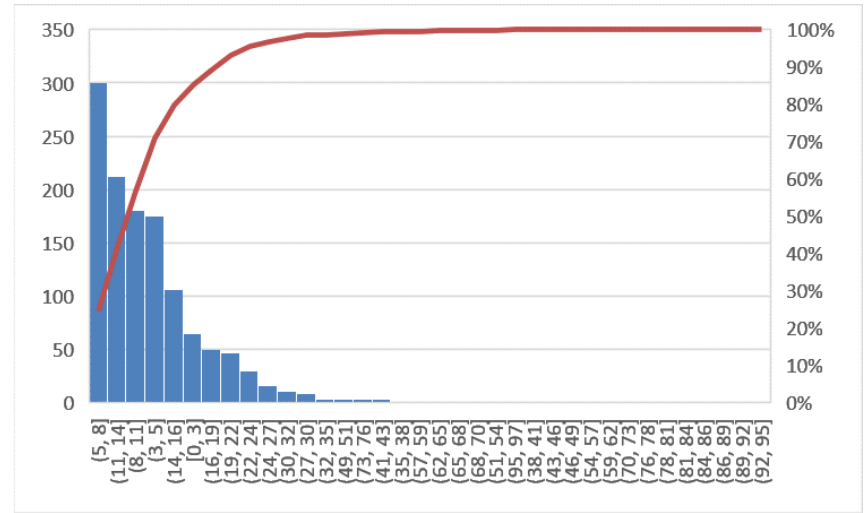
Figure 6. Pareto diagram of LOS (2020, 2021).